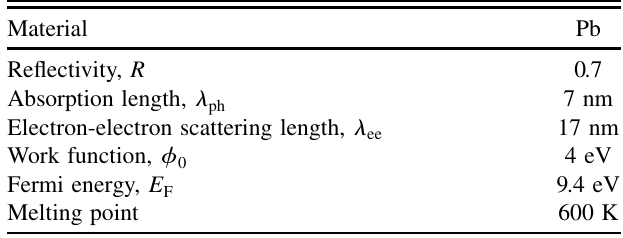
TABLE I. Pb properties at room temperature and photon wavelength of 258 nm [5,8,19,20].